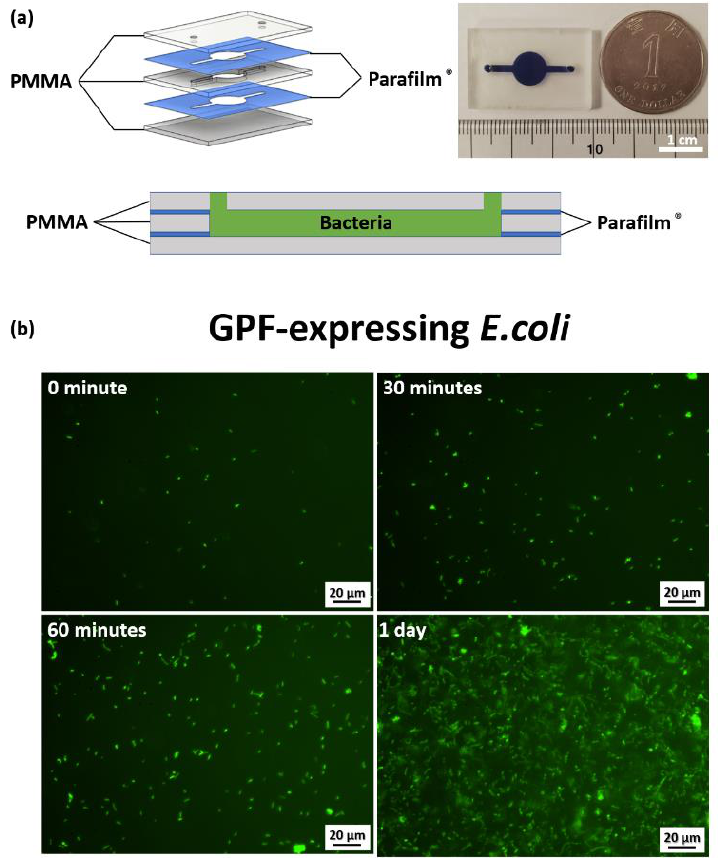
Figure 7. Bacteria cultivation in PbLT-fabricated bioreactor. ( a ) An exploded view and cross-sectional view of the bioreactor and the fabricated bioreactor. ( b ) Fluorescence images were acquired at 0, 30, 60 min, and 1 day post-cultivation in the bioreactor. (Scale bar = 20 μm).